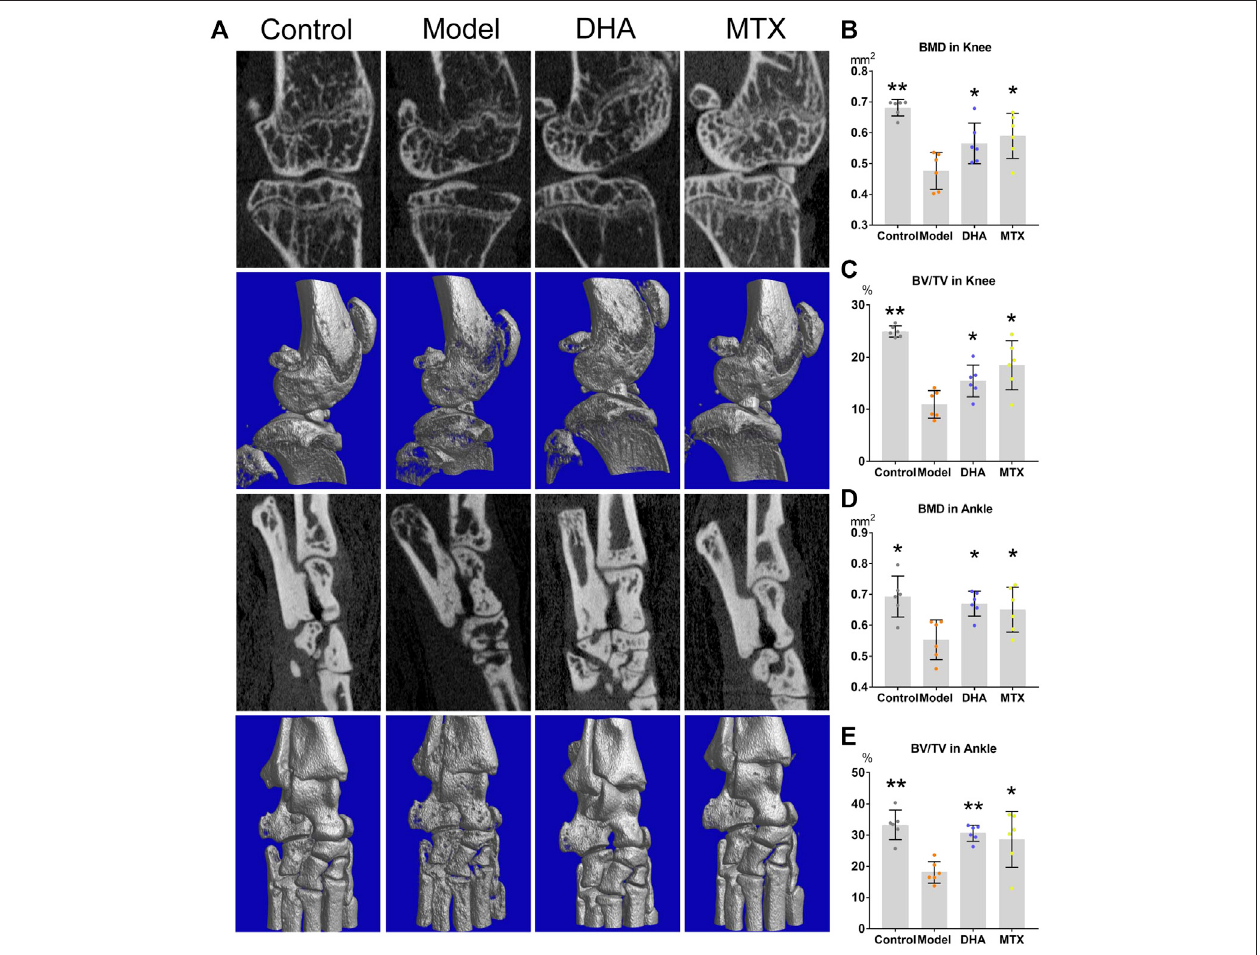
FIGURE 2 | DHA treatment mitigated CIA bone erosion. (A) The right hind ankle and knee of each mouse were collected and scanned using the Skyscan 1,176 Micro-CT Imaging System. (B – E) The bone mineral density (BMD) and bone volume/tissue volume (BV/TV) were calculated. * p < 0.05, ** p < 0.001 vs. the model